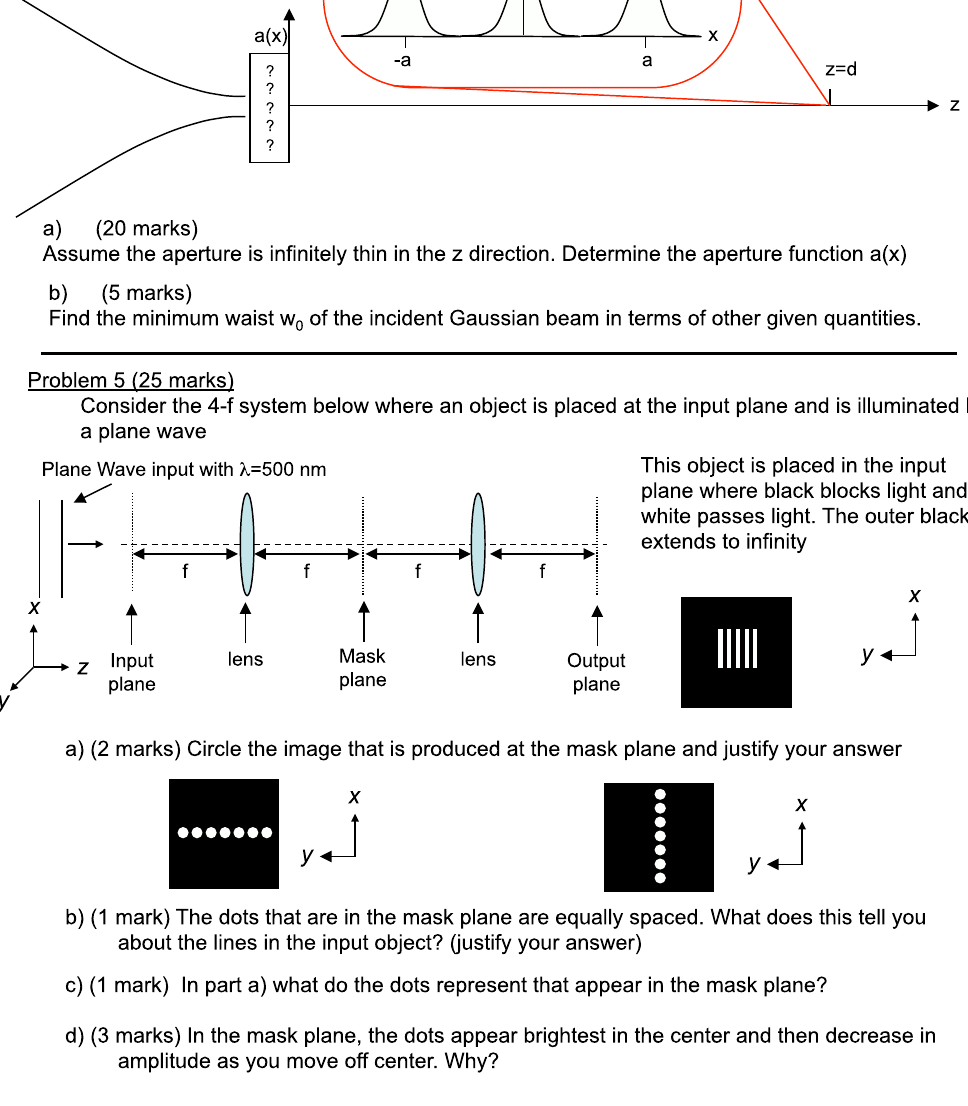
FIG. 6. Examples of exam problems covering subjects of Gaussian beams, diffraction, and Fourier